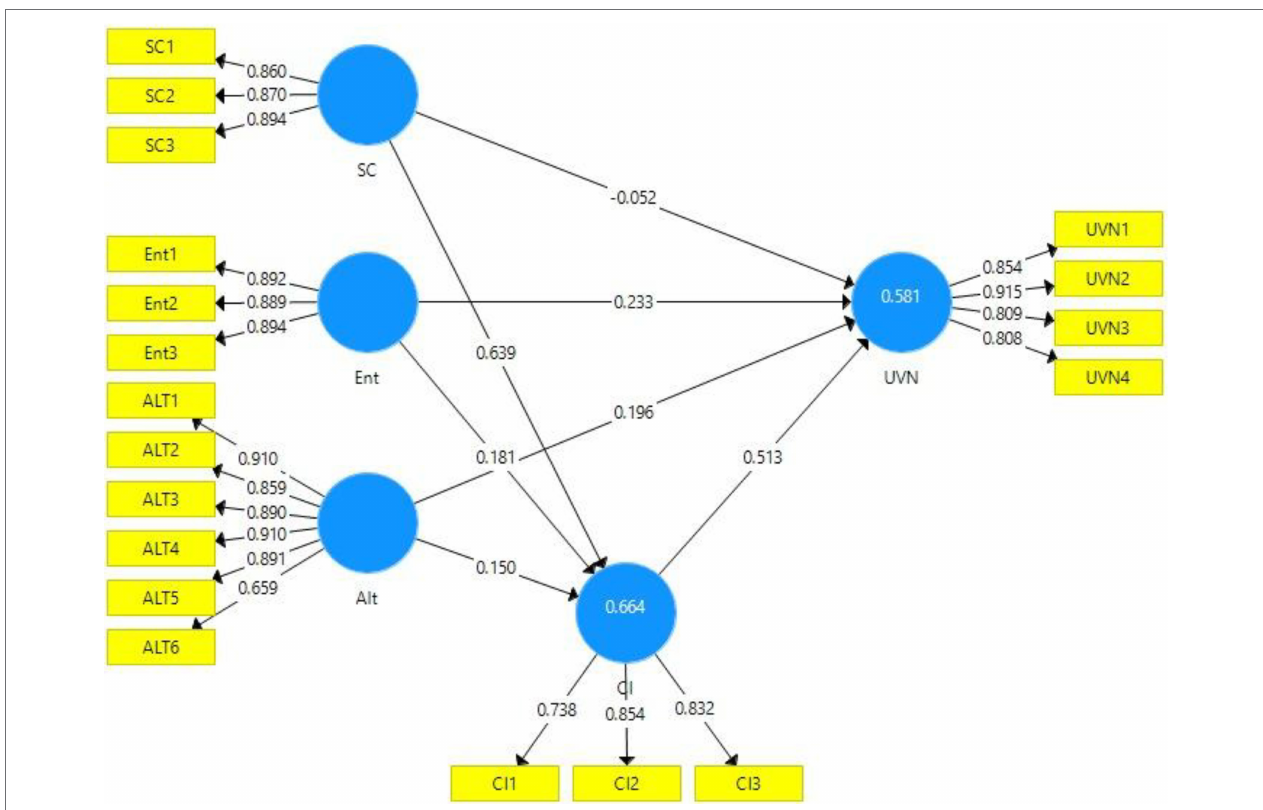
FIGURE 2 | Output of measurement model without moderation. SC, Social Consciousness of Employees; Ent, Entertainment; Alt, Altruism; UVN, Unverified News Sharing; and CI, Corporate